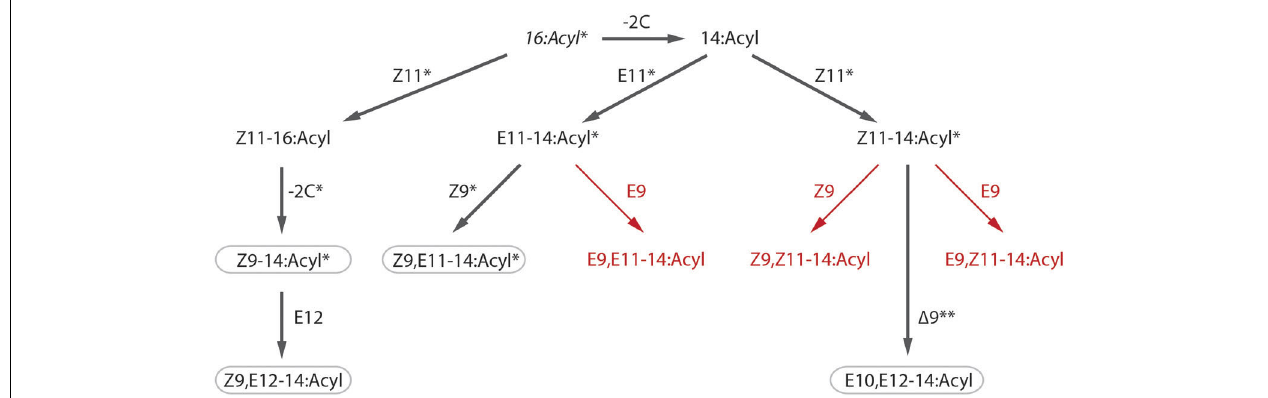
FIGURE 4 | Putative biosynthetic pathway of Spodoptera littoralis female sex pheromone. Steps confirmed by labeling experiments by Munoz et al. (2008) are indicated with asterisks ( ∗ ), including β -oxidation ( − 2C), desaturation ( Z 11, E 11, Z 9, E 9) and double bond